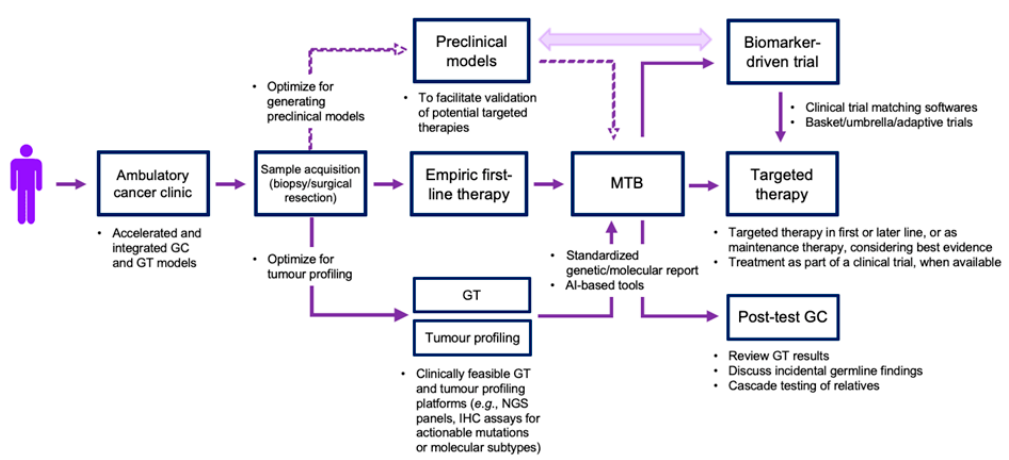
Figure 1. Framework outlining strategies to facilitate implementation of PDAC precision oncology in clinical care. Dotted lines highlight the value of generating preclinical models in parallel, if such platforms are available. Double-headed arrow depicts the potential use of preclinical models to (1) inform precision oncology trial designs and (2) gain mechanistic understanding of treatment responses and acquired treatment resistance observed in biomarker-driven clinical trials. GC, genetic counselling; GT, germline testing; MTB, molecular tumor board; AI, artificial intelligence.